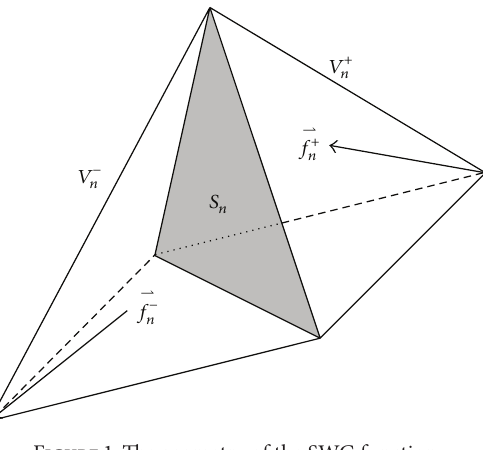
Figure 1: The geometry of the SWG